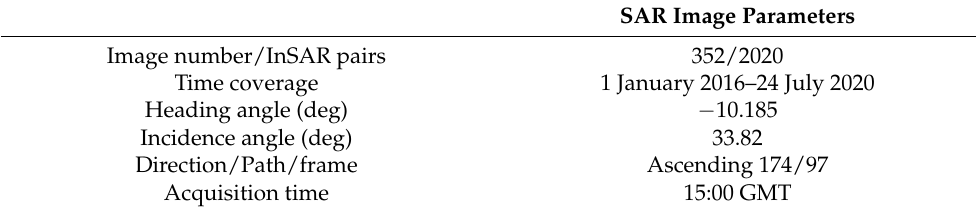
Table 1. Characteristics of employed Sentinel-1